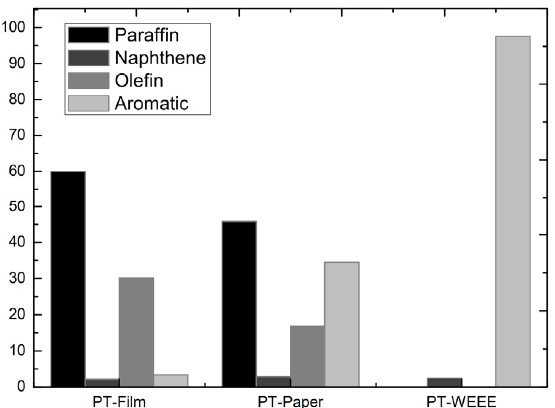
Figure 3. Composition of pyrolysis oils coming from pre-treated samples.